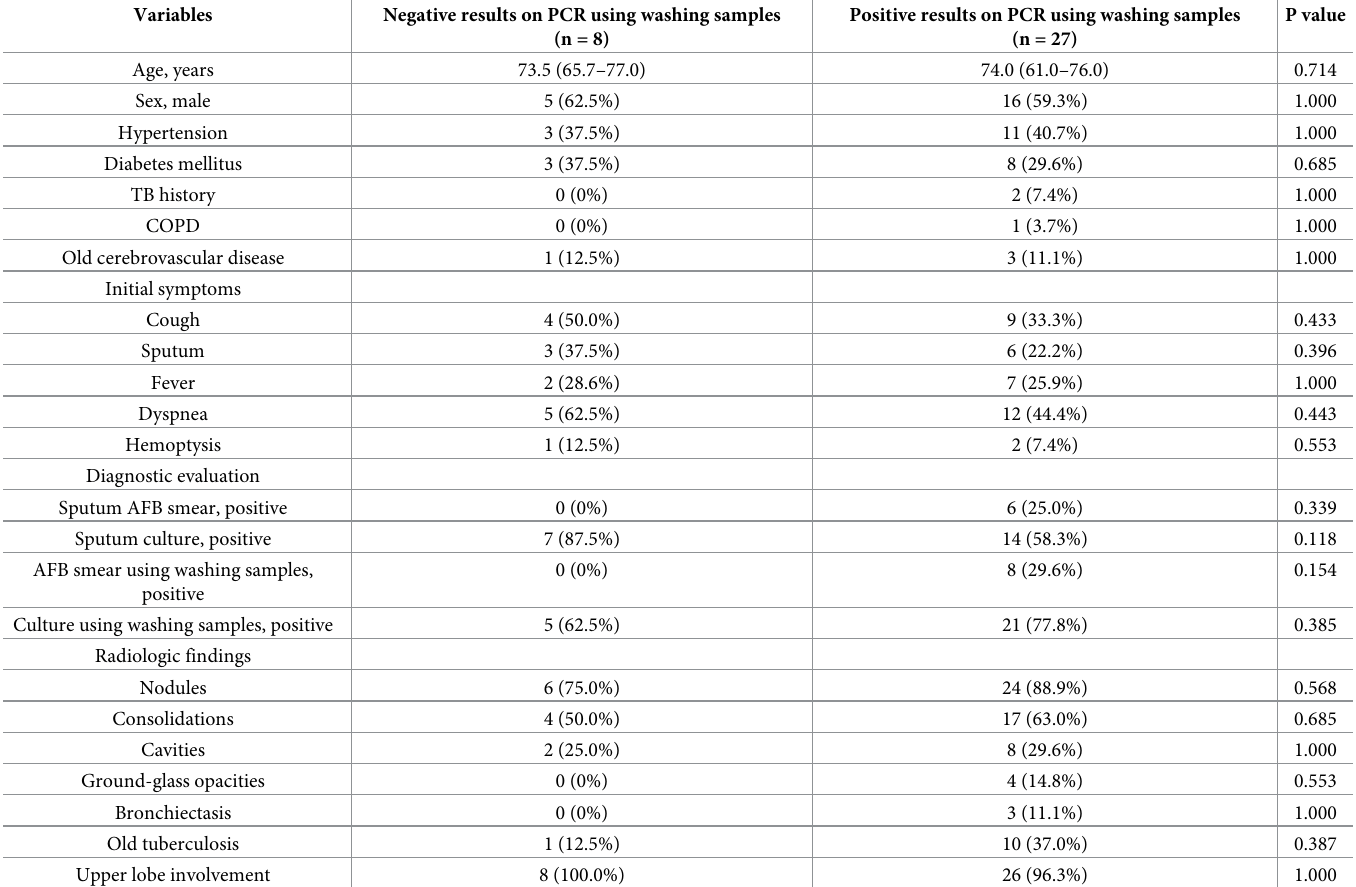
Of the patients who showed negative results for MTB-PCR using sputum and washing sam- ples, eight were diagnosed with TB. Age and sex were similar between the TB subgroups with negative (n = 8) and positive results (n = 27) on MTB-PCR using washing samples (Table 4). Table 4. Subgroup analysis of patients with tuberculosis.